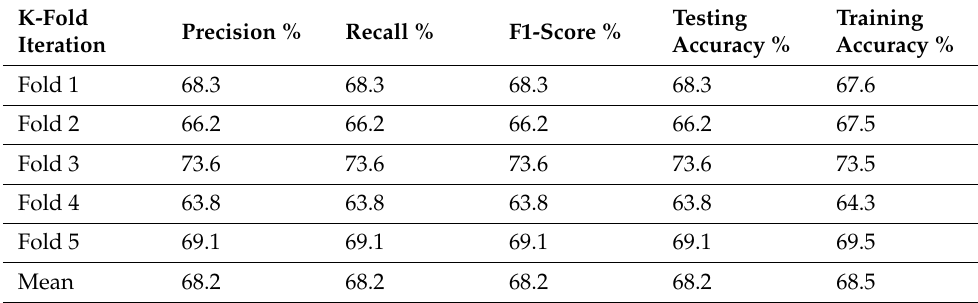
Table 6. The results of the AdaBoost classifier using five-fold cross-validation.